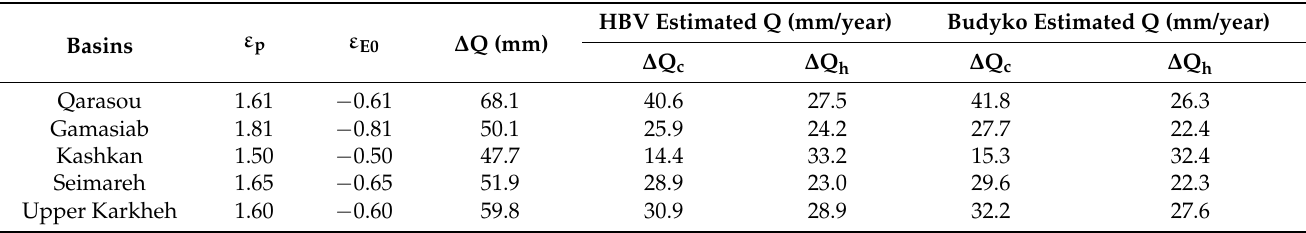
Table 6. Comparison between the HBV model and Budyko method for estimation of streamflow changes in the studied sub-basins.